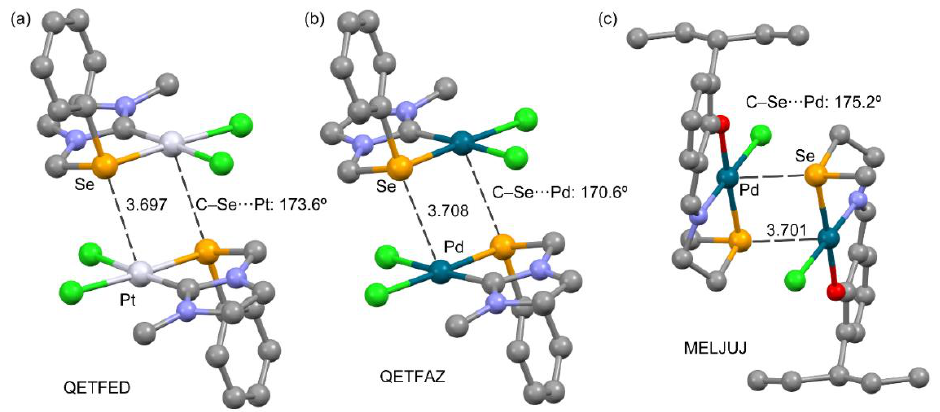
Figure 10. Partial views of the X-ray structures of refcodes QETFED ( a ), QETFAZ ( b ) and MELJUJ ( c ). Distances in Å . H-atoms omitted for clarity.